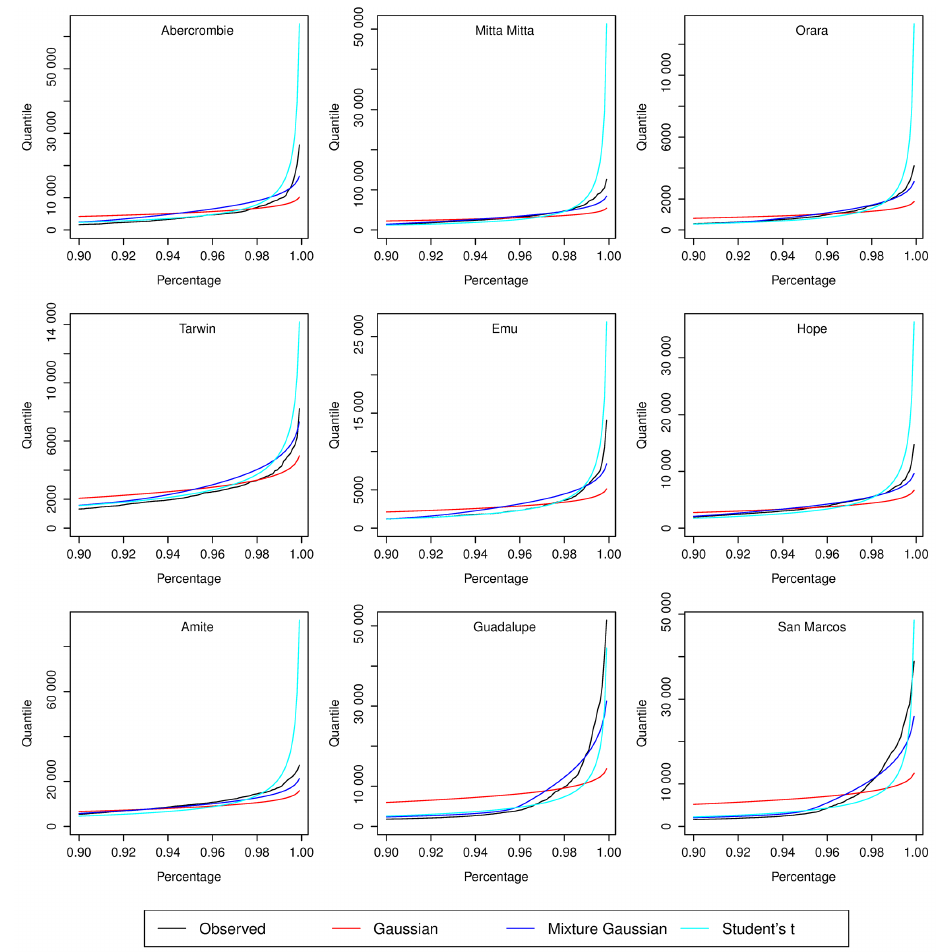
Figure 6. Comparison of the upper quantile of the model residuals fitted by different distributions for each catchment. Table 5. The calibrated parameters when Student’s t distribution is used to describe the residual distribution at Stage 4. Abercrombie Mitta Mitta